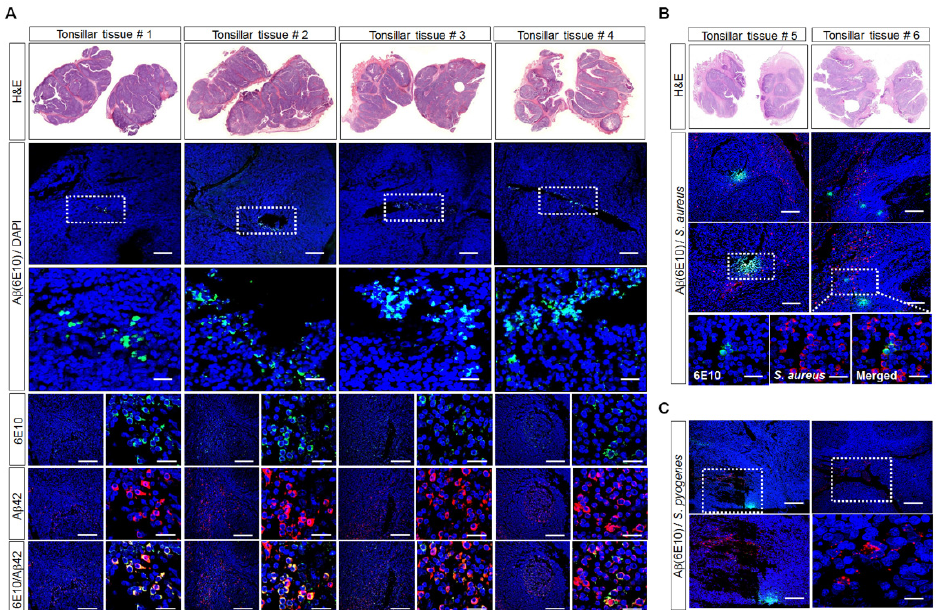
Figure 1. Microscopic images of human palatine-tonsil specimens subjected to immunohistostaining. ( A ) H&E images after the staining of the paraffin-embedded sections or confocal-microscopy images after the staining of the paraffin-embedded sections with the 6E10 antibody (green) or A β 42 antibody (red) to detect A β deposition. The boxed area indicates the 6E10- or A β 42 -positive cells in the human palatine-tonsil specimens (tissue #1, 7 years old; tissue #2, 49 years old; tissue #3, 52 years old; tissue #4, 53 years old). Nuclei were labeled with DAPI (blue). Scale bars: 200 µ m, 100 µ m, 20 µ m. ( B ) H&E images after the staining of the paraffin-embedded sections or confocal-microscopy images after the staining of the sections with the 6E10antibody l (green) or S. aureus antibody (red). The boxed area indicates the 6E10- or S. aureus -positive cells in the human palatine-tonsil specimens (tissue #5, 59 years old; tissue #6, 50 years old). Nuclei were labeled with DAPI (blue). Scale bars: 200 µ m, 100 µ m, 10 µ m. ( C ) Confocal-microscopy images after the staining of the sections with the 6 × 10 10 antibody (green) or S. pyogenes antibody (red). The boxed area indicates the 6E10- or S. aureus - positive cells in the human palatine-tonsil specimen. Nuclei were labeled with DAPI (blue). Scale bars: 200 µ m, 100 µ m, 10 µ m. All images are representative of two or three independent ex- periments.